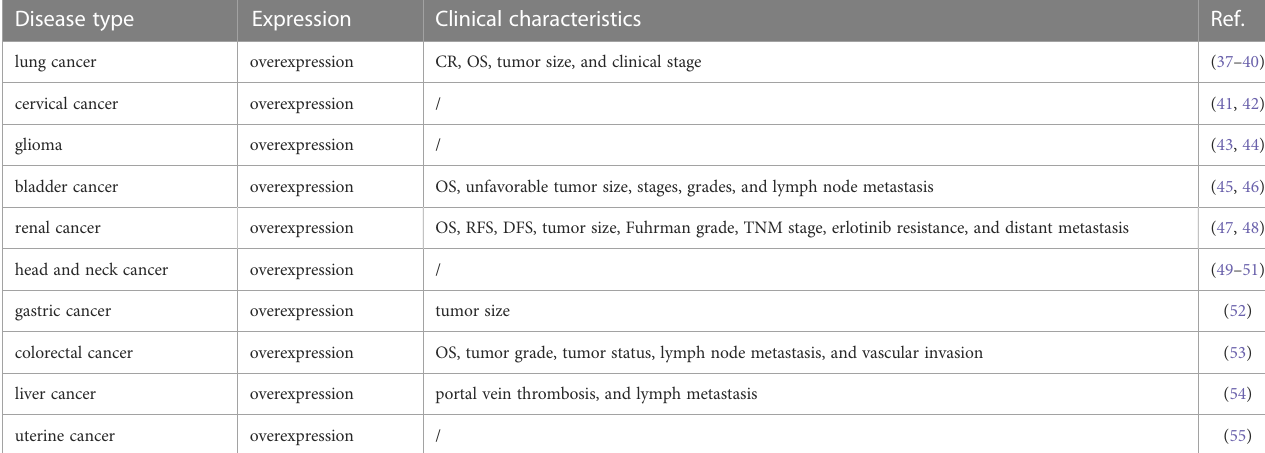
TABLE 1 EGFR-AS1 expression and clinical characteristics in cancers.